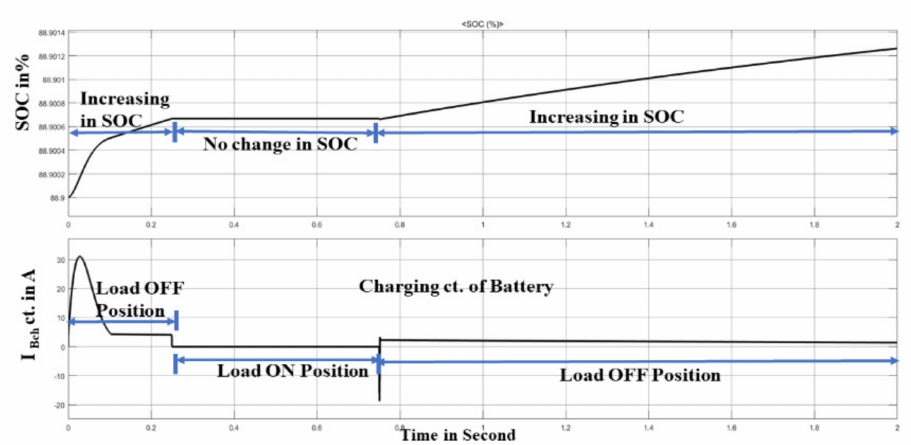
Figure 7. SOC and various load conditions for the main